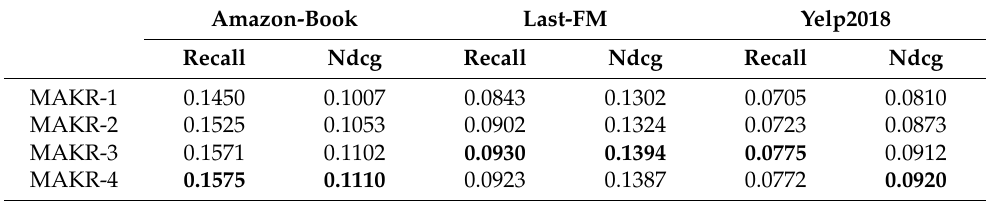
Table 3. Effect of embedding propagation layer numbers (L).